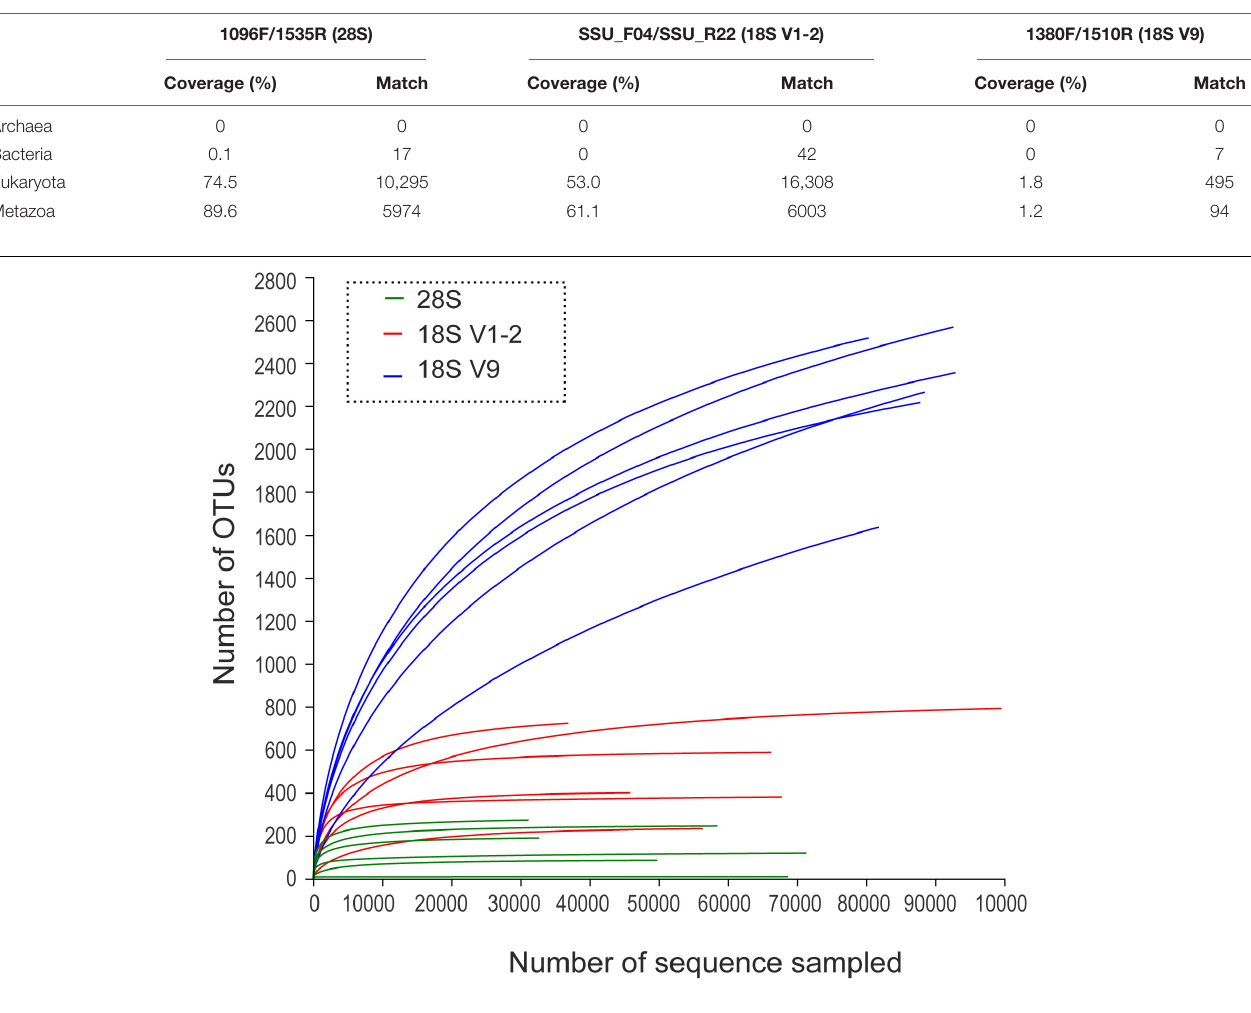
FIGURE 1 | Rarefaction curves of OTU numbers for the 28S, 18S V1-2, and 18S V9 metabarcoding markers.